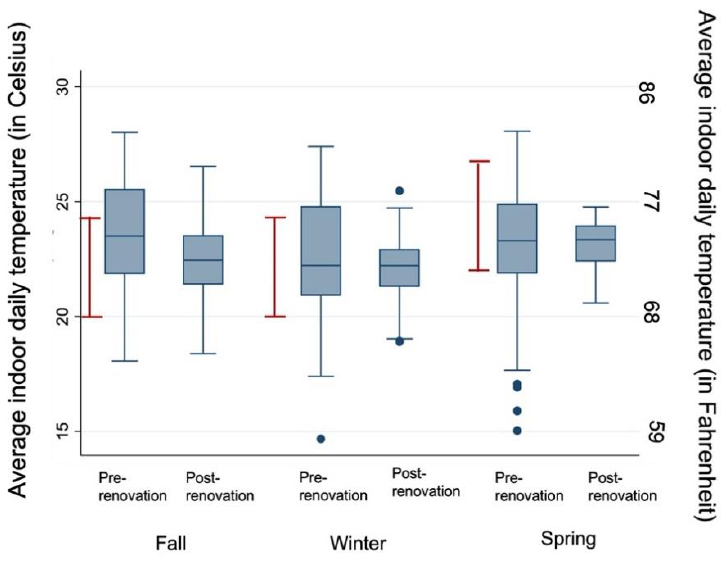
Figure 2. Indoor school daily temperature by school renovation status and season in seven schools with pre- and post-renovation data. The boxes demonstrate the IQR of average indoor daily temperature. Whiskers represent closest value within 1.5 × the IQR of the average indoor daily temperature. Blue dots represent individual values that extend beyond the whisker values. Red lines indicate recommended indoor temperature guidelines from ASHRAE: 68–75 ◦ F (20–23.9 ◦ C) in fall/winter and 73–80 ◦ F (22.8–26.7 ◦ C) in the spring/summer. Indoor school daily temperatures were measured between 8:00 a.m. and 4:00 p.m.